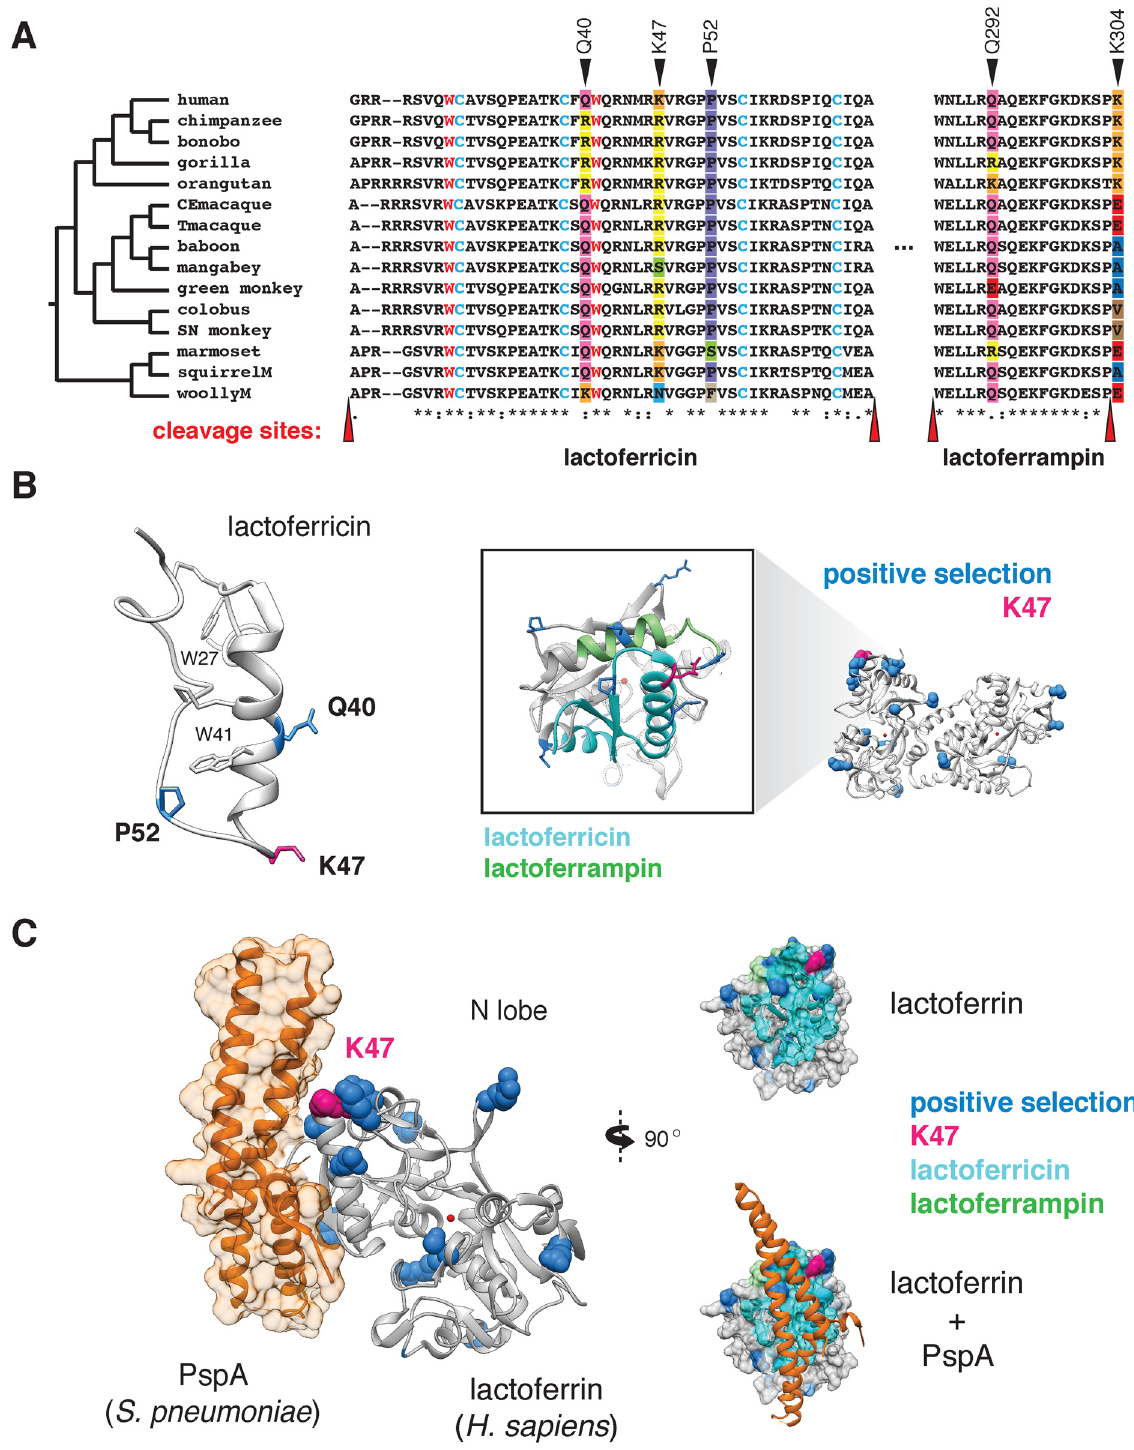
Fig 3. Rapid evolution of lactoferrin-derived antimicrobial peptides and pathogen binding interfaces. A. Amino acid alignment of the lactoferricin and lactoferrampin peptide sequences across primates. Sites under positive selection are denoted with black arrows, with amino acids at these positions color-coded. Conserved tryptophan (red) and cysteine (blue) residues are highlighted, which contribute to target membrane interactions and disulfide bond formation respectively. The reported cleavage sites of the two peptides are denoted with red arrows. B. Left: solution structure of the free human lactoferricin peptide (PDB: 1Z6V),